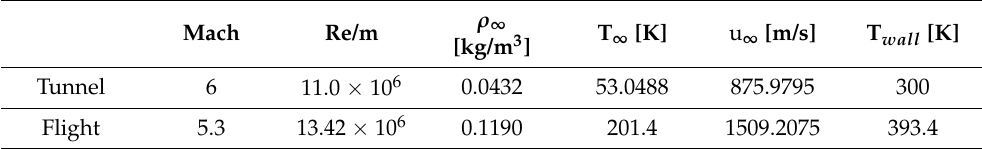
Figure 1. Mach contours for Case B: A 1 m long, 7 ◦ half opening angle, 1 mm circular nose bluntness, straight cone at flow conditions consistent with those expected in AFOSR-Notre Dame Large Mach 6 Quiet Tunnel. Distance along the axis of the cone is given in meters. Table 1. Test